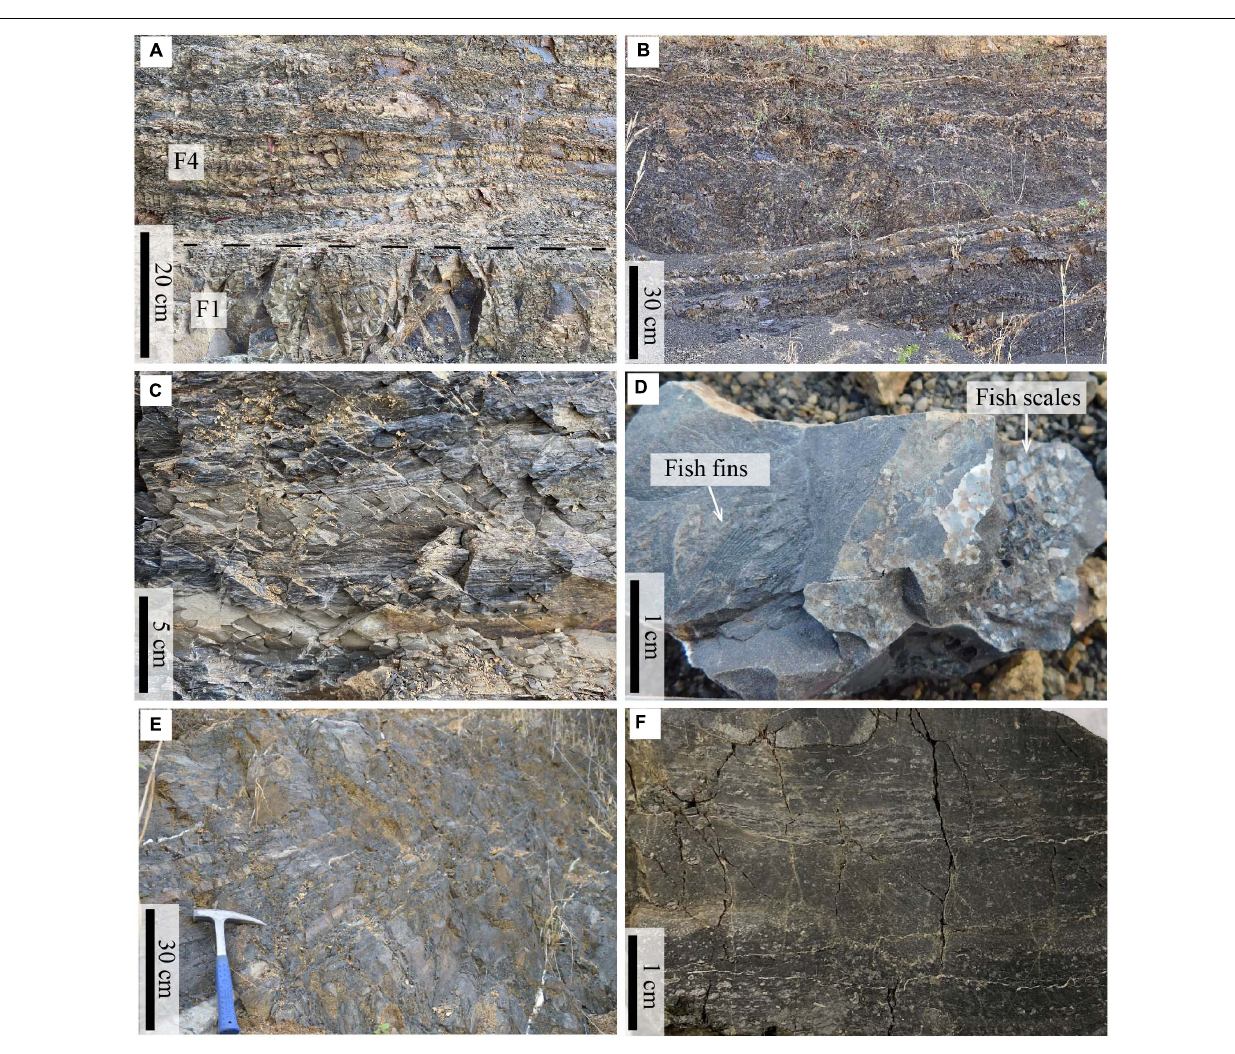
Frontiers in Earth Science |